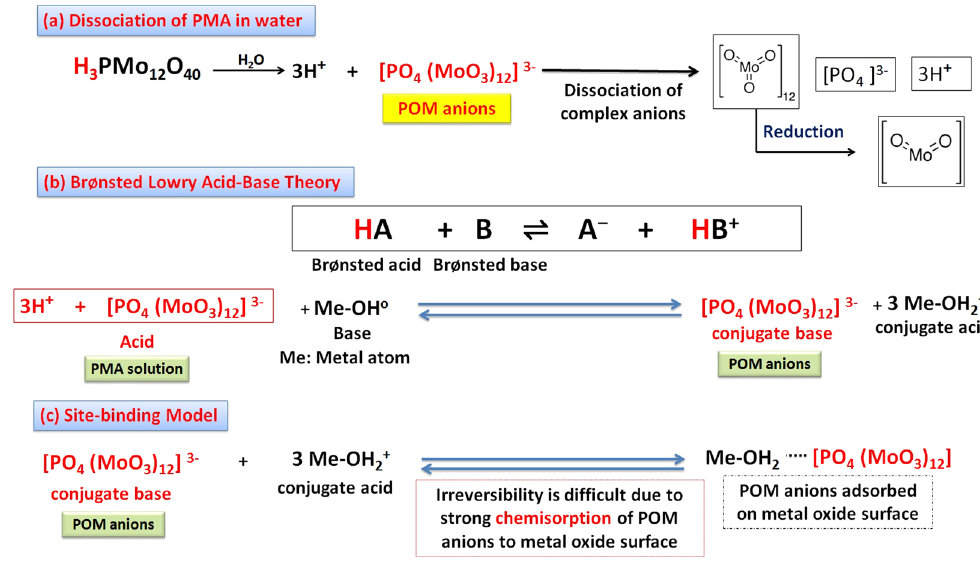
Figure 10. Shows dissociation equation for phosphomolybdic acid (PMA) in water ( a ), the behavior of hydroxyl group on metal oxide surface as Brønsted base site (accept protons) ( b ), and the adsorption of (POM anions) to amphoteric metal oxide surface according to site-binding model ( c